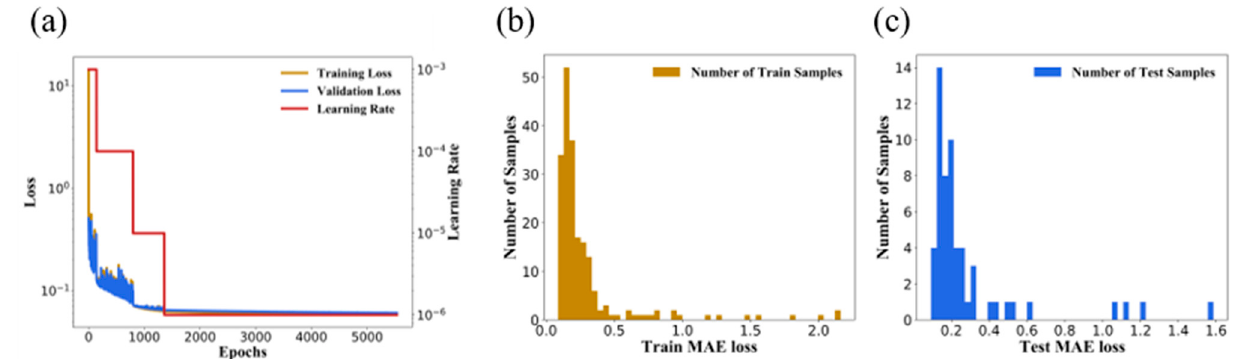
Figure 3. ( a ) The performance of the deep Resnet under training; ( a ) The training loss curve, the validation loss curve, and the learning rate curve as the training epochs increased; ( b ) The distribution of the number of training samples with different training MAE losses; ( c ) The distribution of the number of test samples with different testing MAE losses on the testing set.